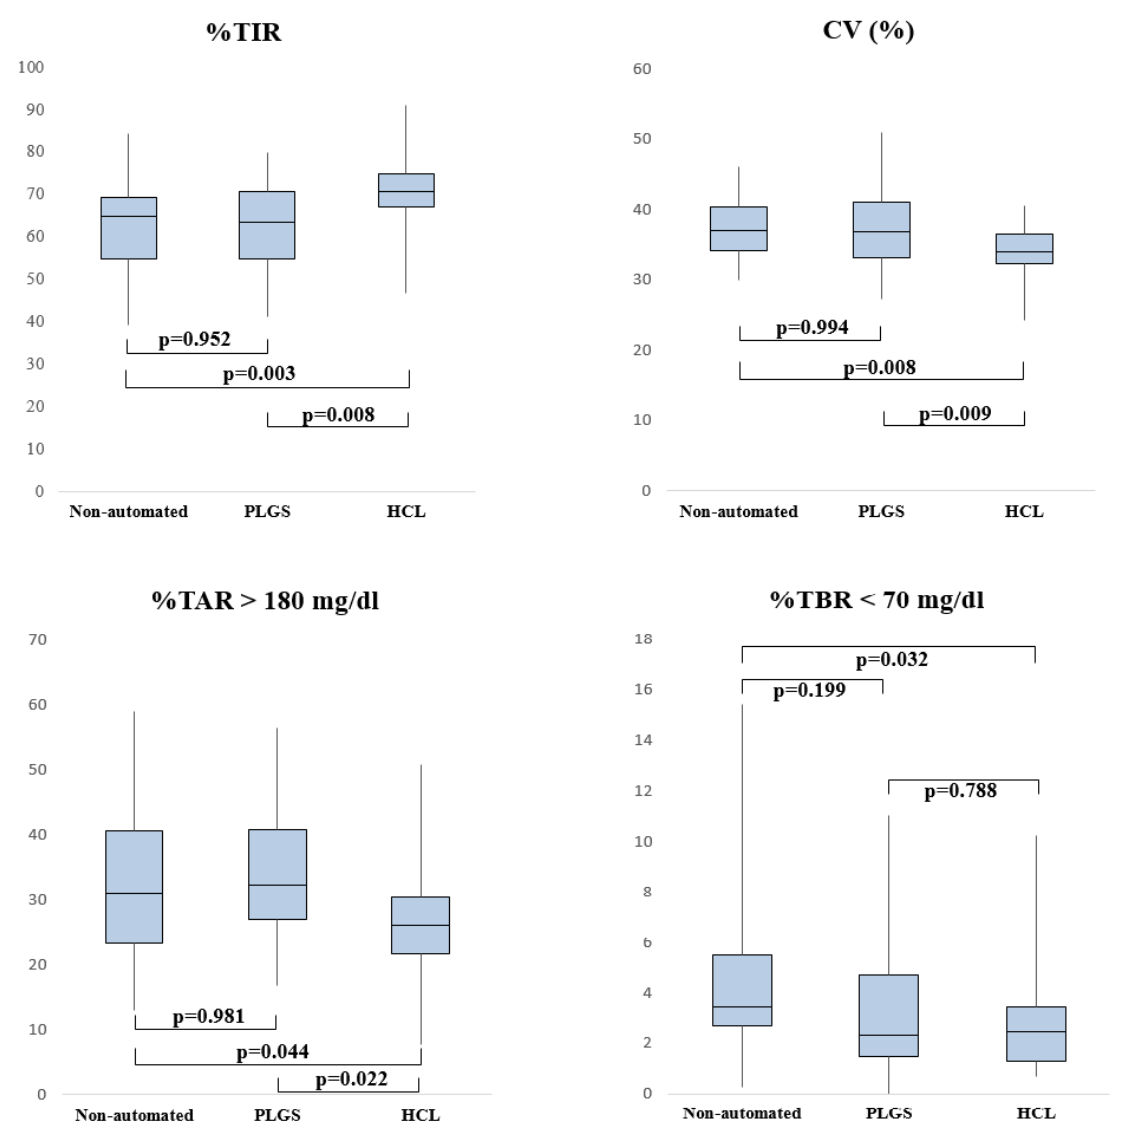
Figure 2. Boxplots illustrating the distribution of the main CGM metrics (%TIR, %TAR > 180 mg/dL, %TBR < 70 mg/dL, CV) in two-by-two comparisons between three different subgroups.